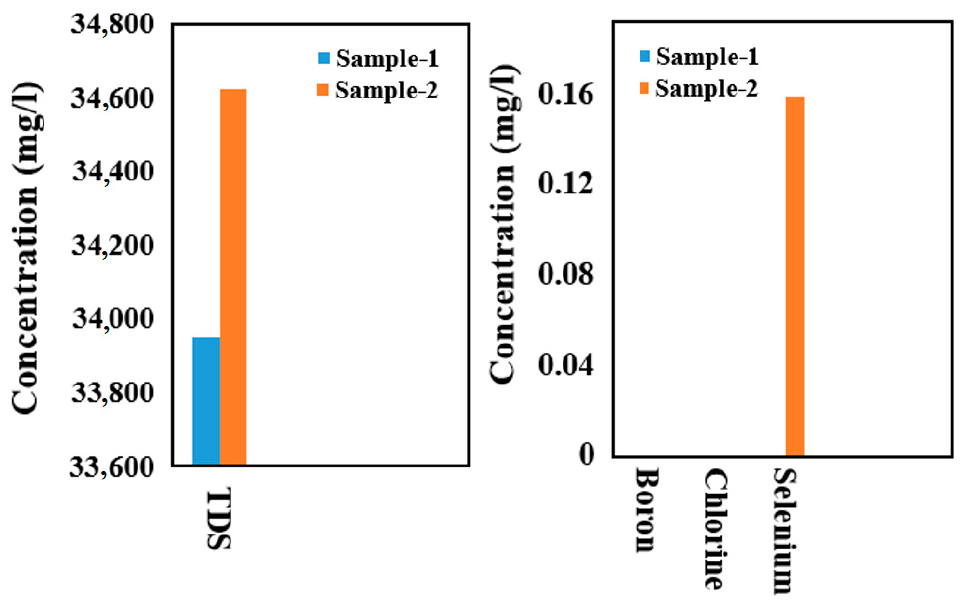
Figure 3. Concentration (mg/L) of TDS, boron, chloride and selenium ions in wastewater samples-1 and -2.